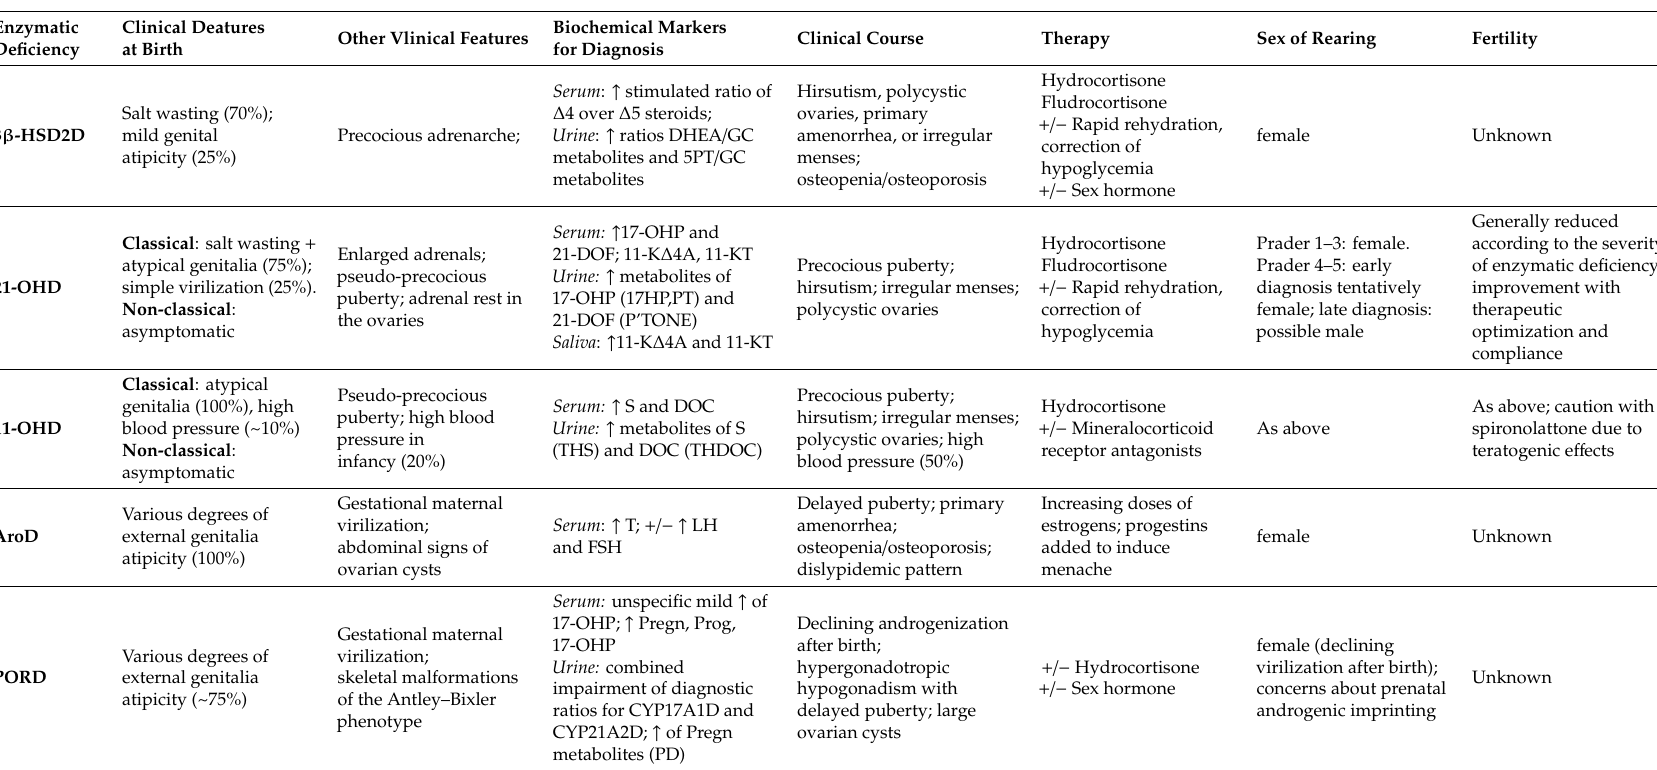
Table 2. A summary of clinical and biochemical features, therapy, and clinical course of the disease in 46,XX di ff erences of sex development (DSD). Enzymatic